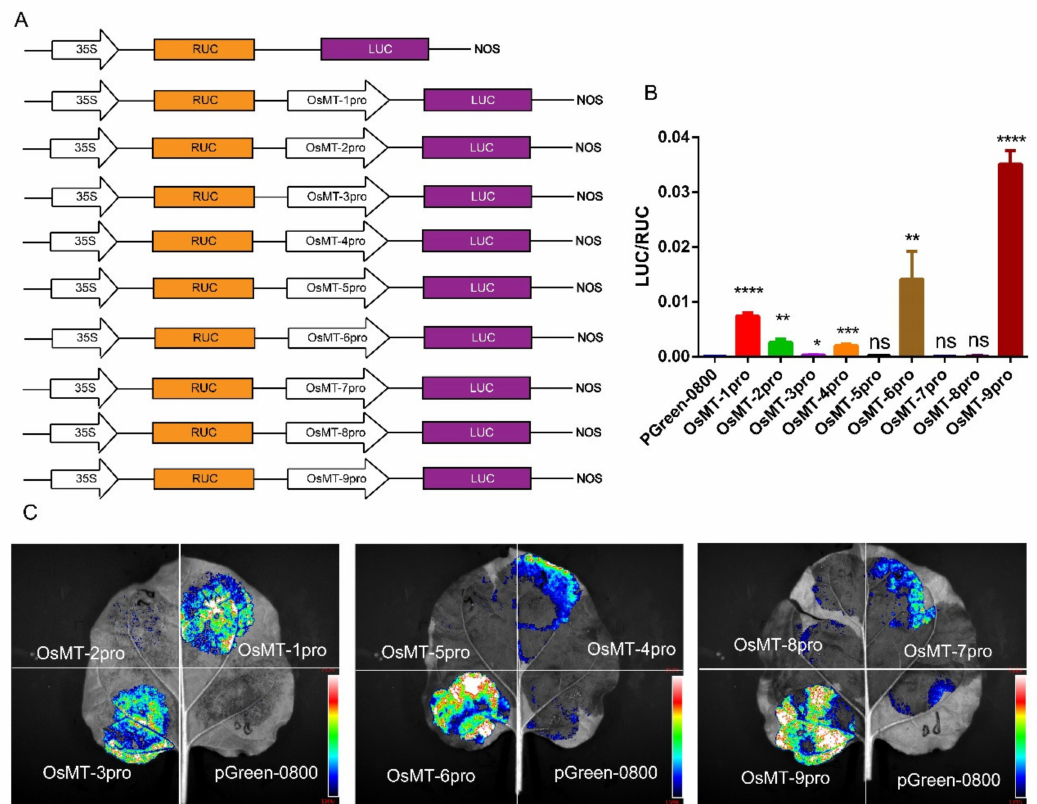
Figure 4. Analysis of the promoter function of OsMT genes in vivo: ( A ) the vector constructs are used in the dual-luciferase assay; ( B ) dual-luciferase assay in the protoplast of rice; ( C ) dual-luciferase assay in Nicotiana benthamiana leaves. The error bars show the standard deviations of the three independent biological replicates. Significance analysis was performed using t -test; *: p < 0.05, **: p < 0.01, ***: p < 0.001, ****: p <